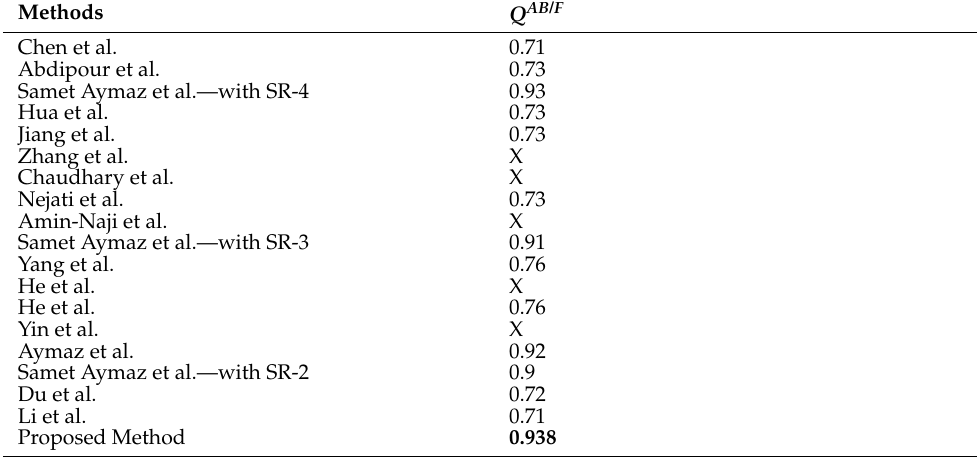
Table 20. The outcomes for the book image and comparisons with existing techniques in the literature ([27]).